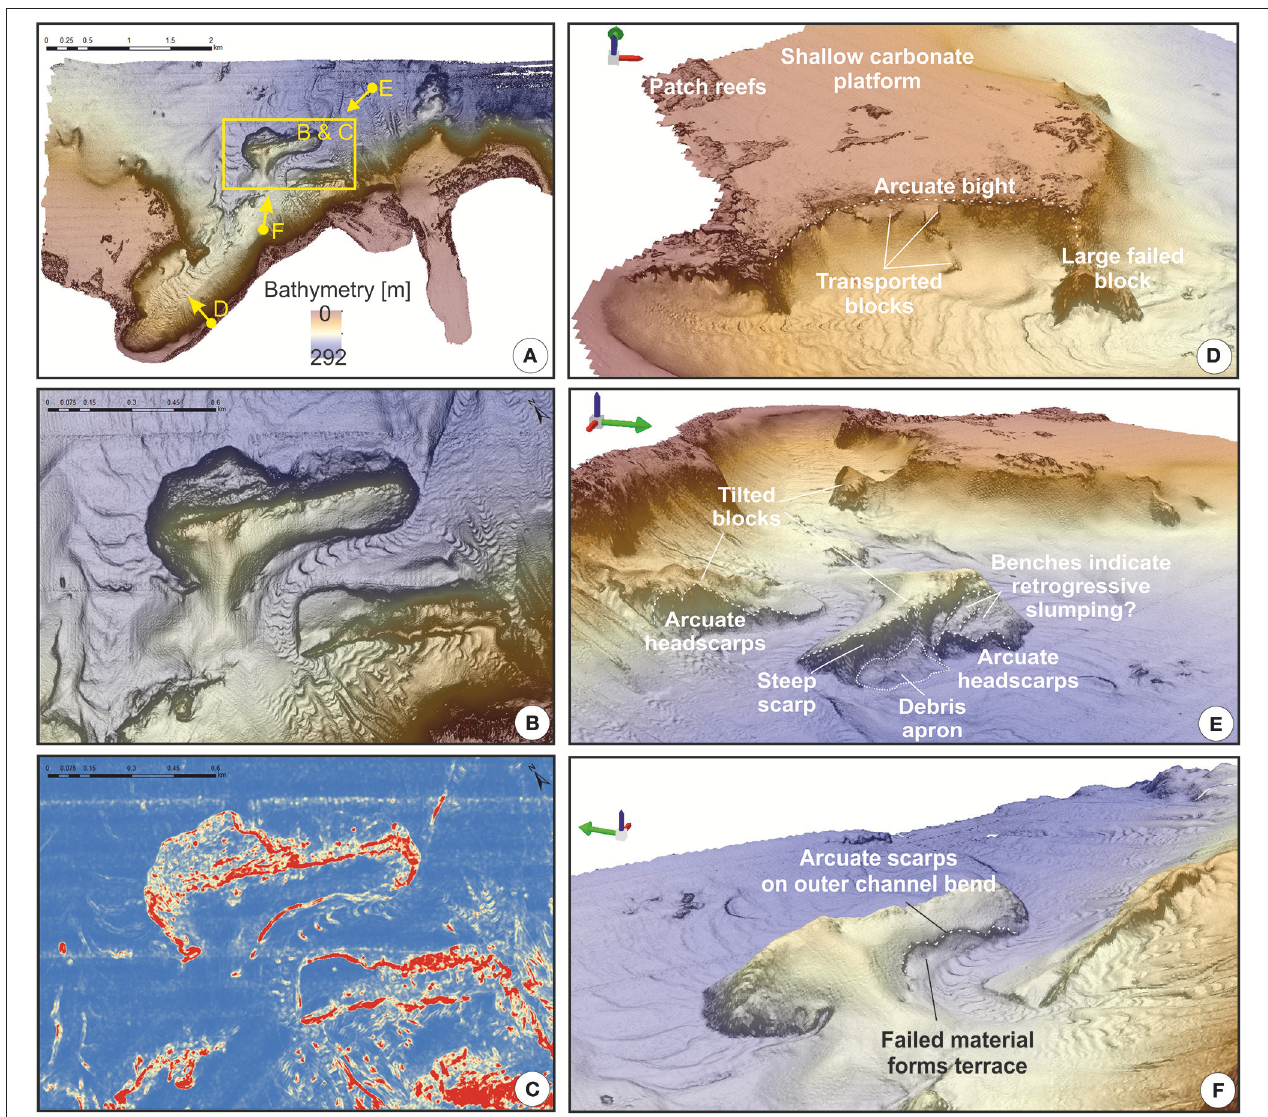
FIGURE 3 | Overview map (A) annotated with panels that illustrate evidence for localized slope instability. Line of sight is illustrated by yellow arrow for the following panels. Slope rendering (B, where black is steepest slope) and seafloor roughness ( C , where red is roughest and blue is smoothest) maps show an elongated, tilted block that may be a failed slab of carbonate platform that has subsequently been eroded around. Arcuate bight-like structures may reflect past episodes of slope instability, and feature smaller blocks that appear to have slumped (D) . High slope angles (B) and roughness (C) on the flanks of the elongated, tilted block may indicate smaller-scale incipient slope failures, which are annotated in 3D renderings (E,F)